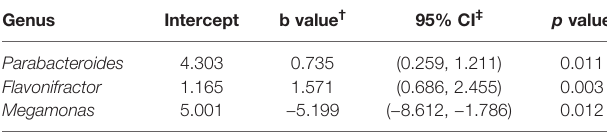
TABLE 3 | GLMs for the signi fi cantly different genera controlling for other confounders between the ICP and healthy groups.